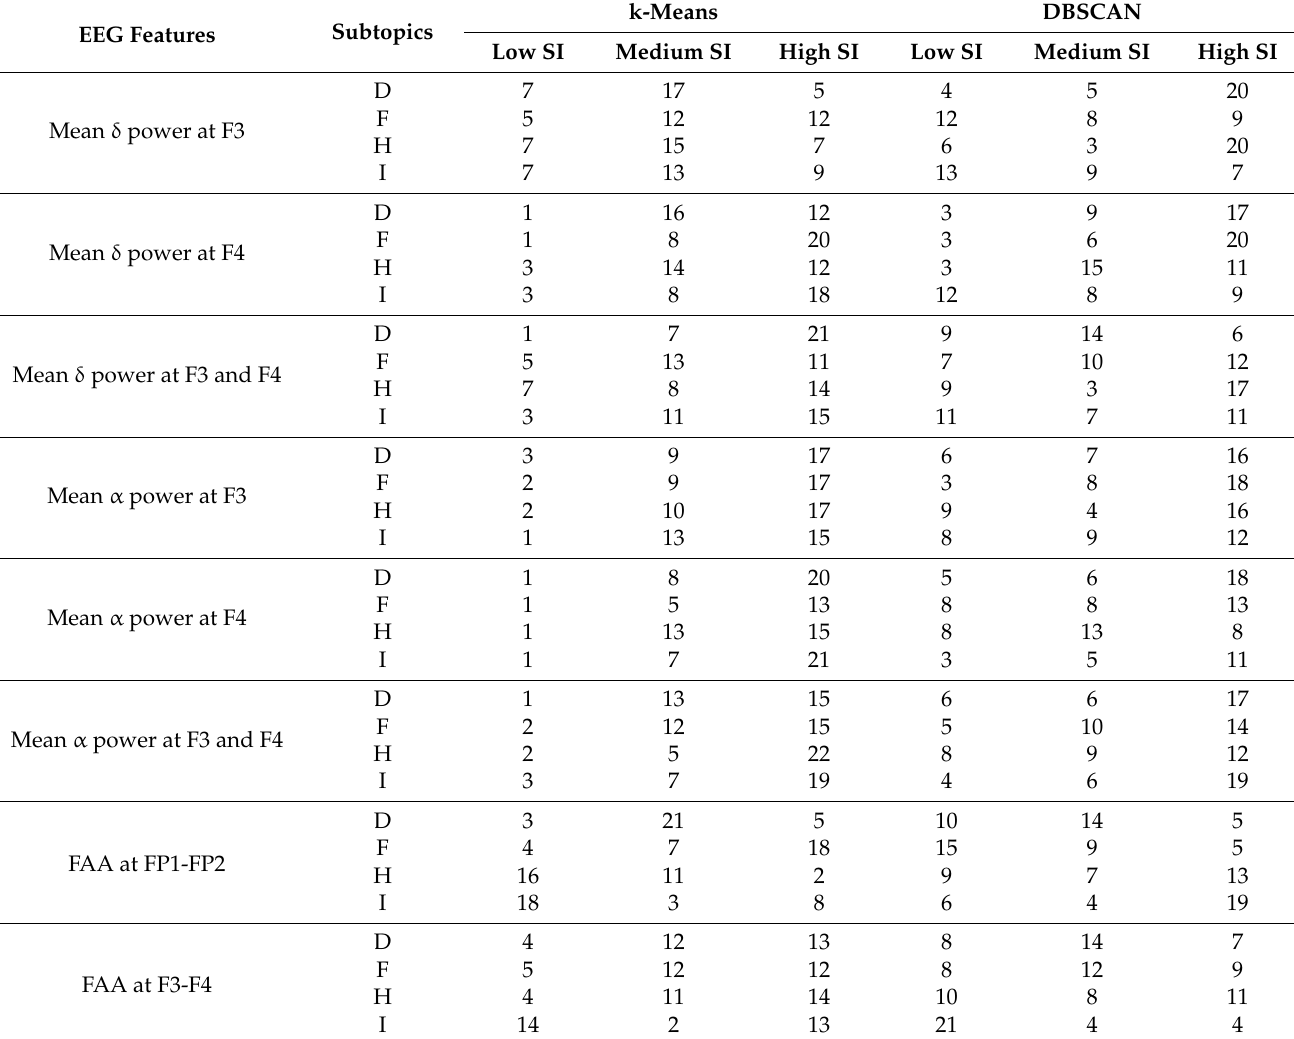
Table 4. A summarization of the clustering results for each EEG feature used in every subtopic.